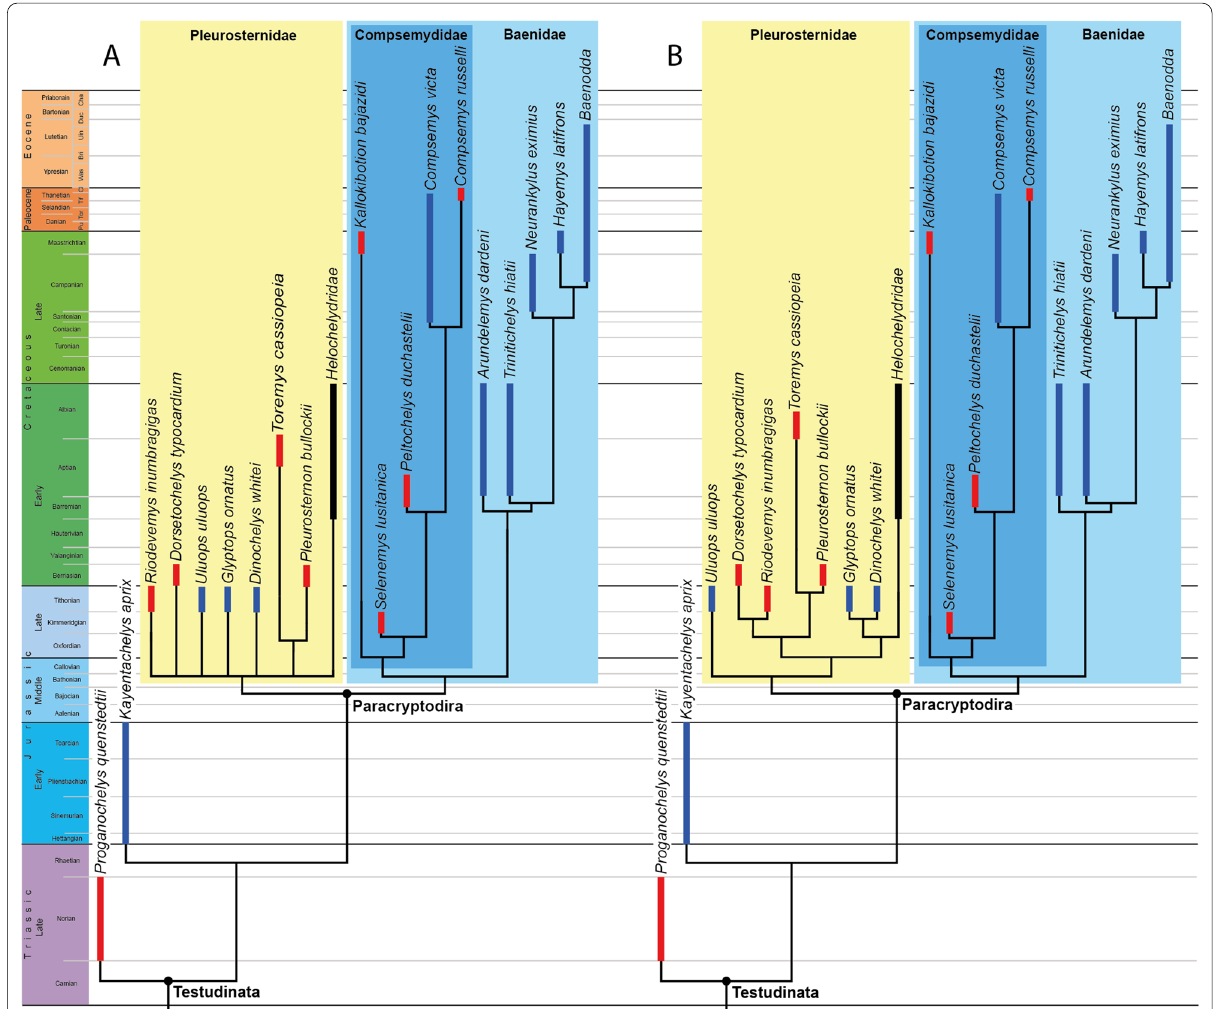
Fig. 10 Time-calibrated phylogenetic hypotheses resulting from the expanded analyses of Joyce and Rollot (2020). A Strict consensus tree obtained from the analysis under equal weighting without the rogue taxa Scabremys ornata , Cedrobaena putorius , and Peckemys brinkman ; B single most parsimonious tree obtained from the analysis with implied weighting and a K value of 6 with a best score of 19.55433. The range of North American taxa is highlighted in blue, the range of European taxa in red, and the range of clades that have both a European and North American distribution in